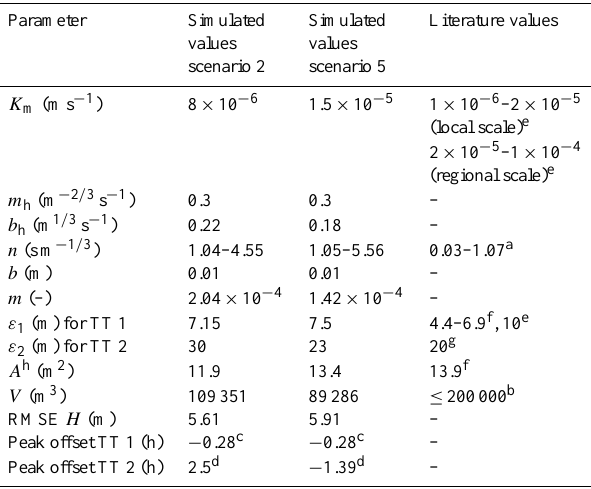
Table 1. Calibrated and simulated parameters for the best-fit simu- lations. Literature values are given if available. TT 1 and TT 2 refer to the two tracer tests.